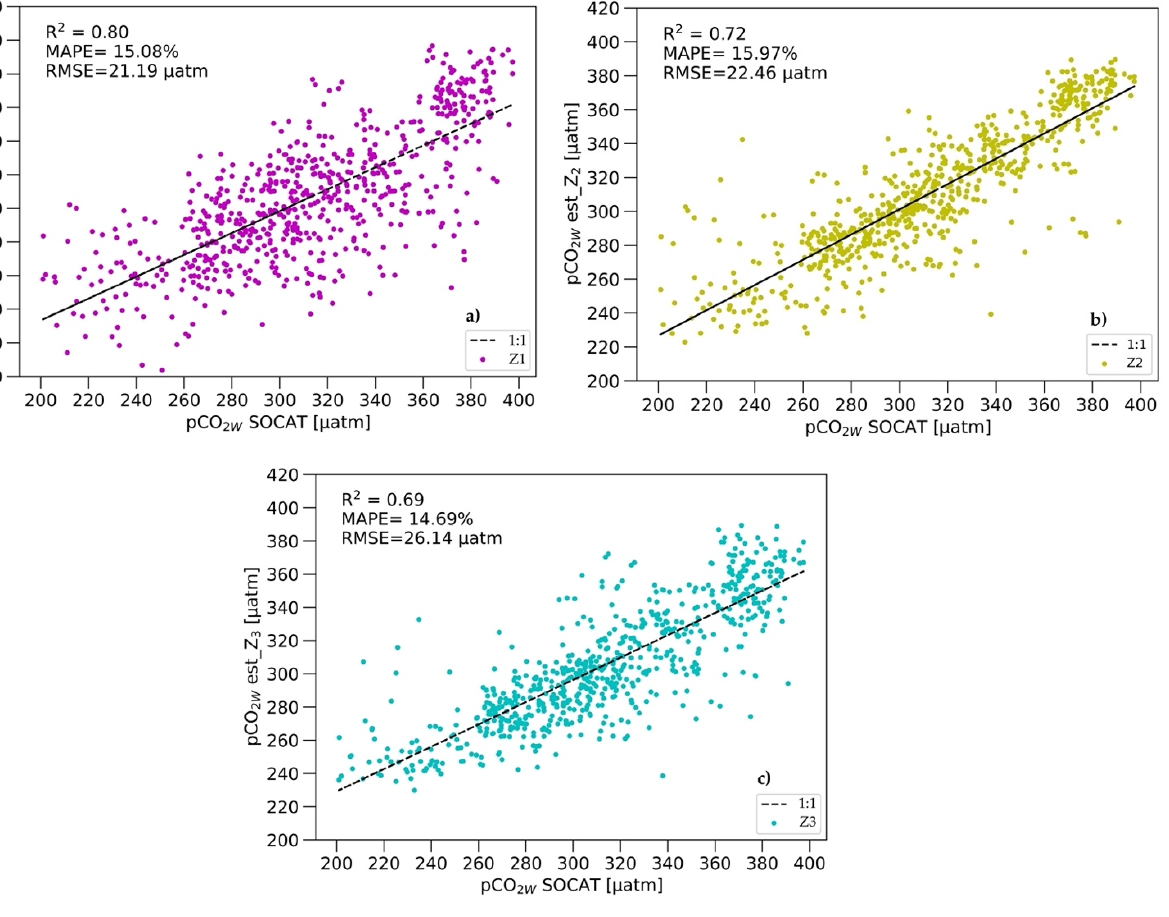
Figure 2. Scatter plot of estimated pCO 2W vs. observed pCO 2W obtained based on three models: ( a ) ( a ) Z 1 ; ( b ) Z 2 ; ( c ) Z 3 for 2013–2017 ( µ Z 1 ; ( b ) Z 2 ; ( c ) Z 3 for 2013–2017 ( 𝜇 atm).